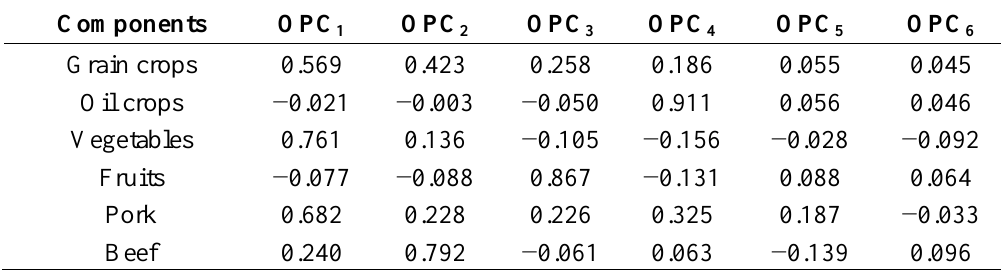
Table 5. Eigenvectors of the output intensity